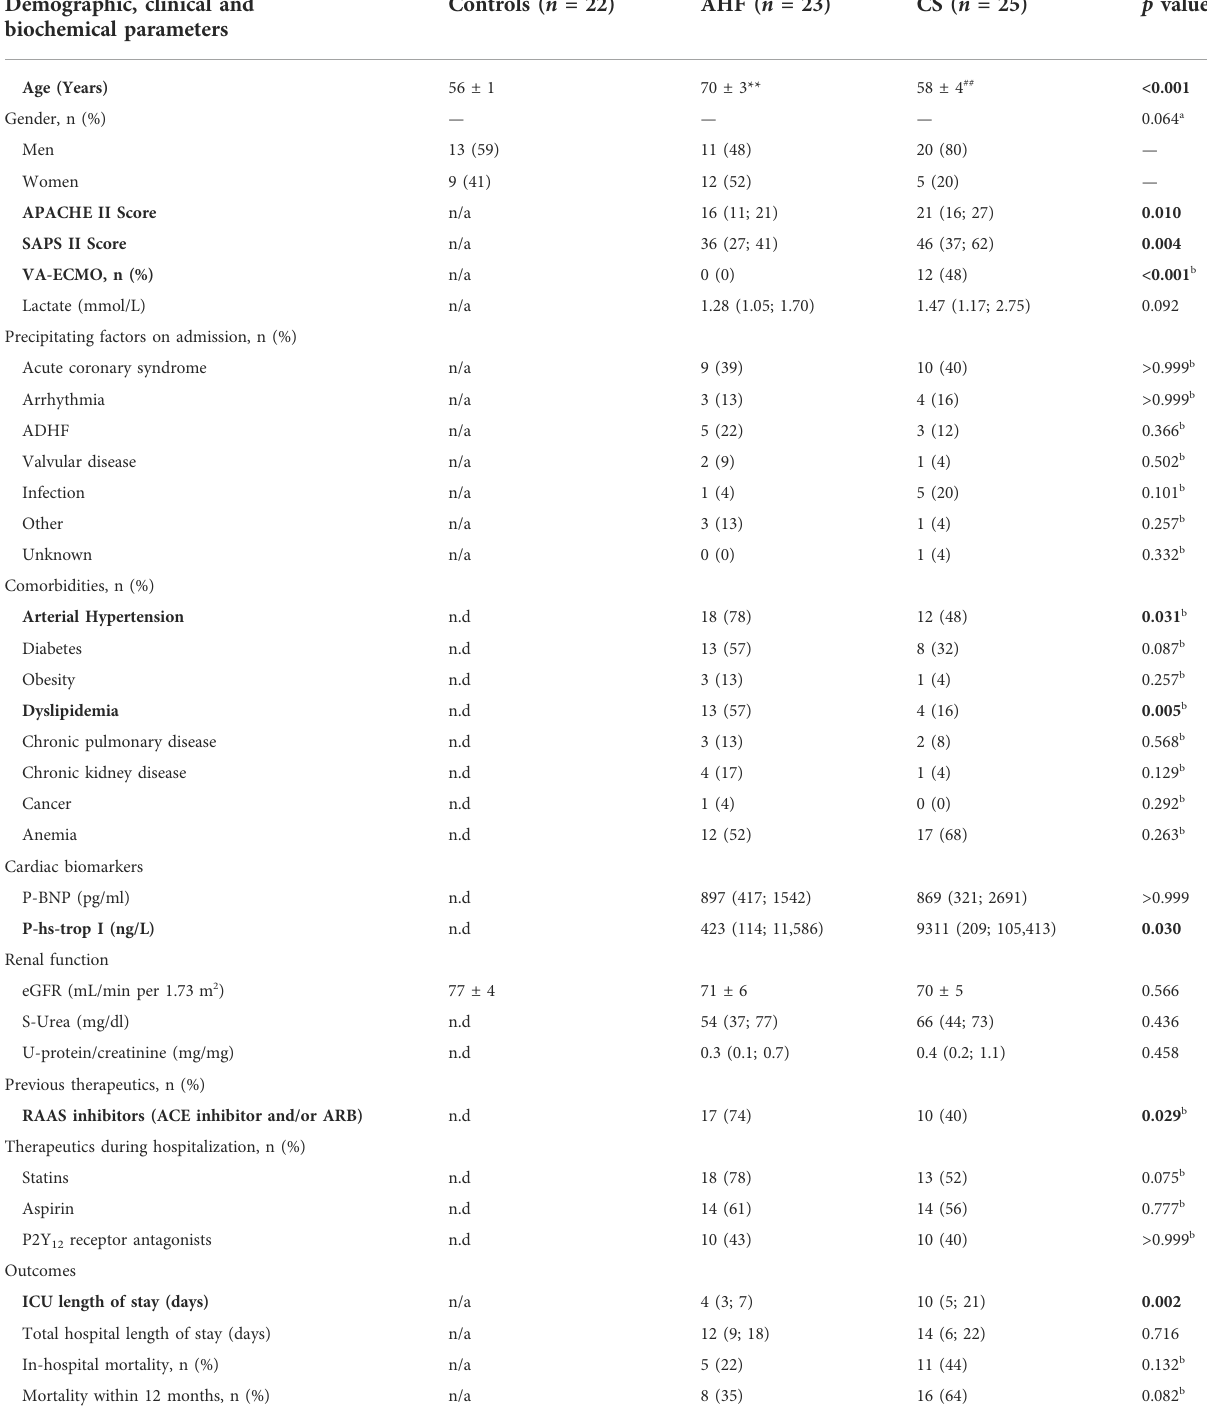
TABLE 1 Demographic, clinical and biochemical characteristics at admission and outcomes of study population. Demographic, clinical and biochemical